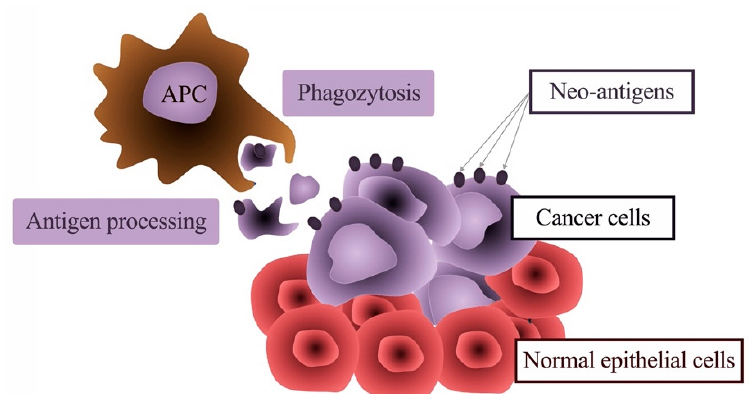
Figure 6. Immunological recognition of neoantigens in dysplastic lesions and tumors. Tumor cells, as well as highly dys- plastic cells, express neoantigens that can be recognized by immune cells, such as professional antigen-presenting cells (APC). The tumor cells can then be phagocytized, and the antigens are processed and finally presented on major histo- compatibility complex (MHC) molecules on T cells. This can initiate an immune reaction against dysplastic cells or cancer cells and therefore prevent the clinical appearance of a cancer disease.